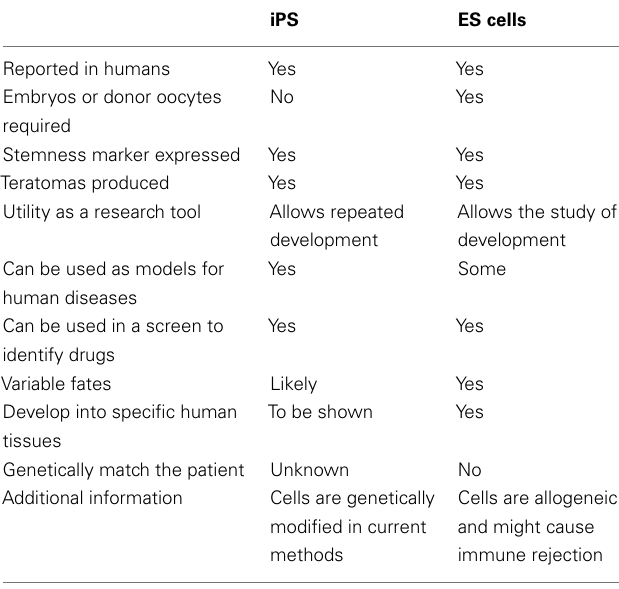
Table 1 | Comparison between ESC and iPSC . iPS ES